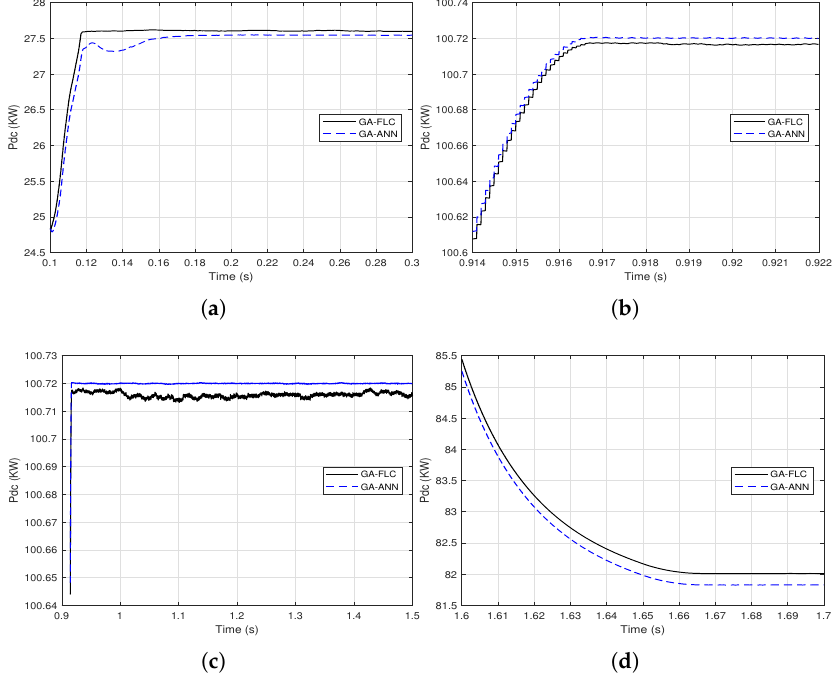
Figure 14. Proximate views of the output DC power of the PV array when using the GA-FLC and the GA-ANN based MPPT methods for linear variations of G and T c : ( a ) from 0.1 to 0.3 s; ( b ) from 0.914 to 0.922 s; ( c ) from 0.9 to 1.5 s; ( d ) from 1.6 to 1.7